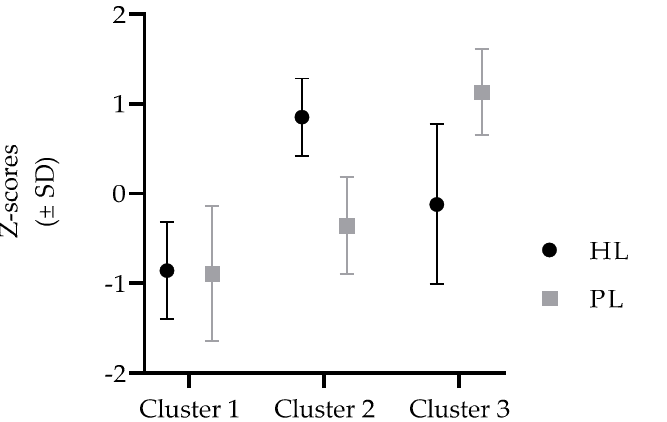
Figure 1. Multivariate clustering on the basis of health literacy (HL) and physical literacy (PL) for boys (results are presented in standardized values).